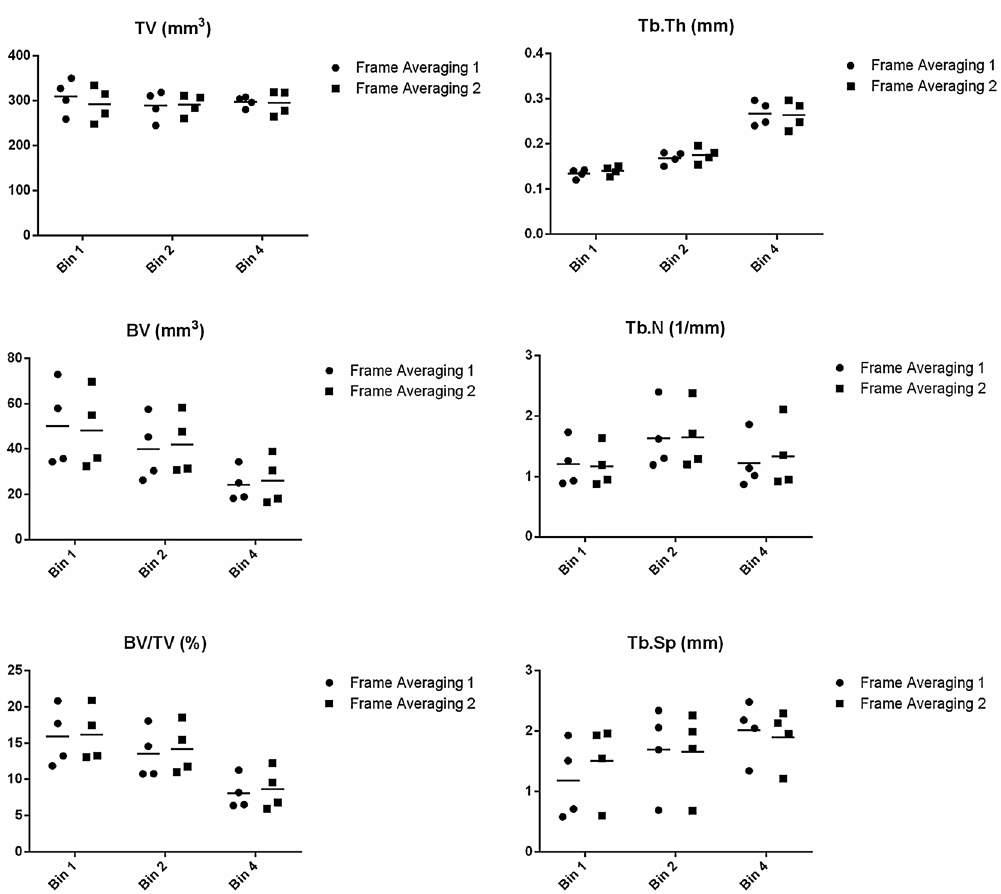
Figure 1. Summary plot for each subject and